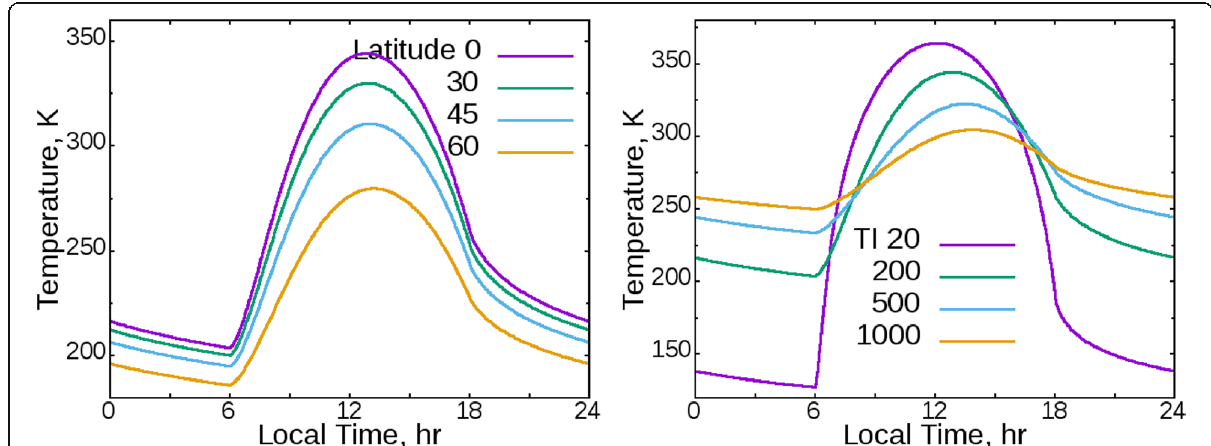
Fig. 8 Surface temperature change as a function of local time for various latitudes (left) and thermal inertia (right). The sub-solar latitude is assumed to be 0